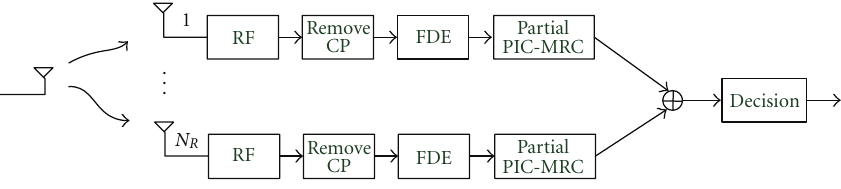
Figure 8: Block diagram of the partial PIC-MRC SIMO SCBT system.